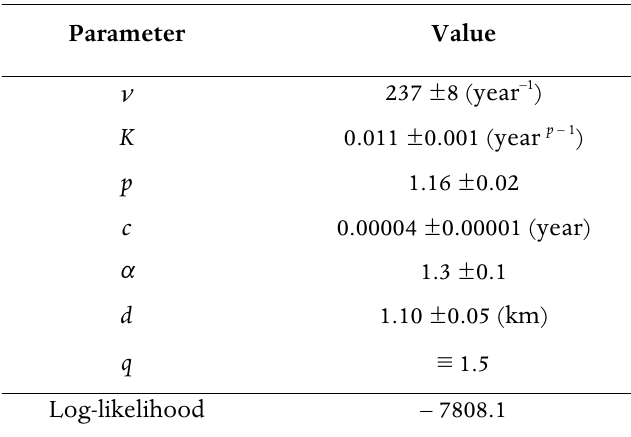
Table 1. Parameters of the ETAS model for Italian seismicity ( M April 16, 2005, to June 1, 2009; 2,100 events).